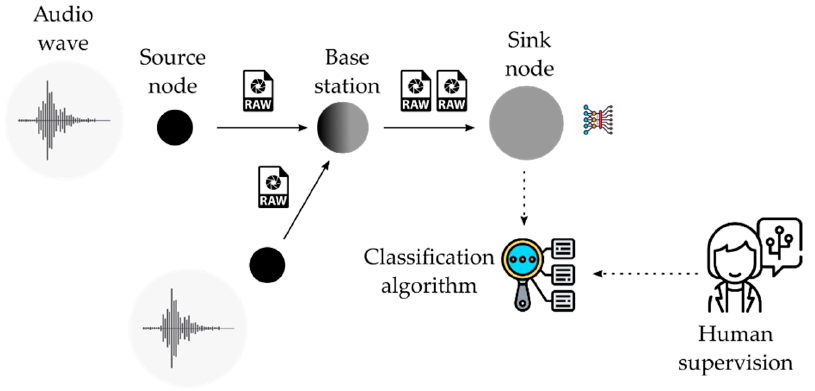
Figure 5. Centralized architecture.